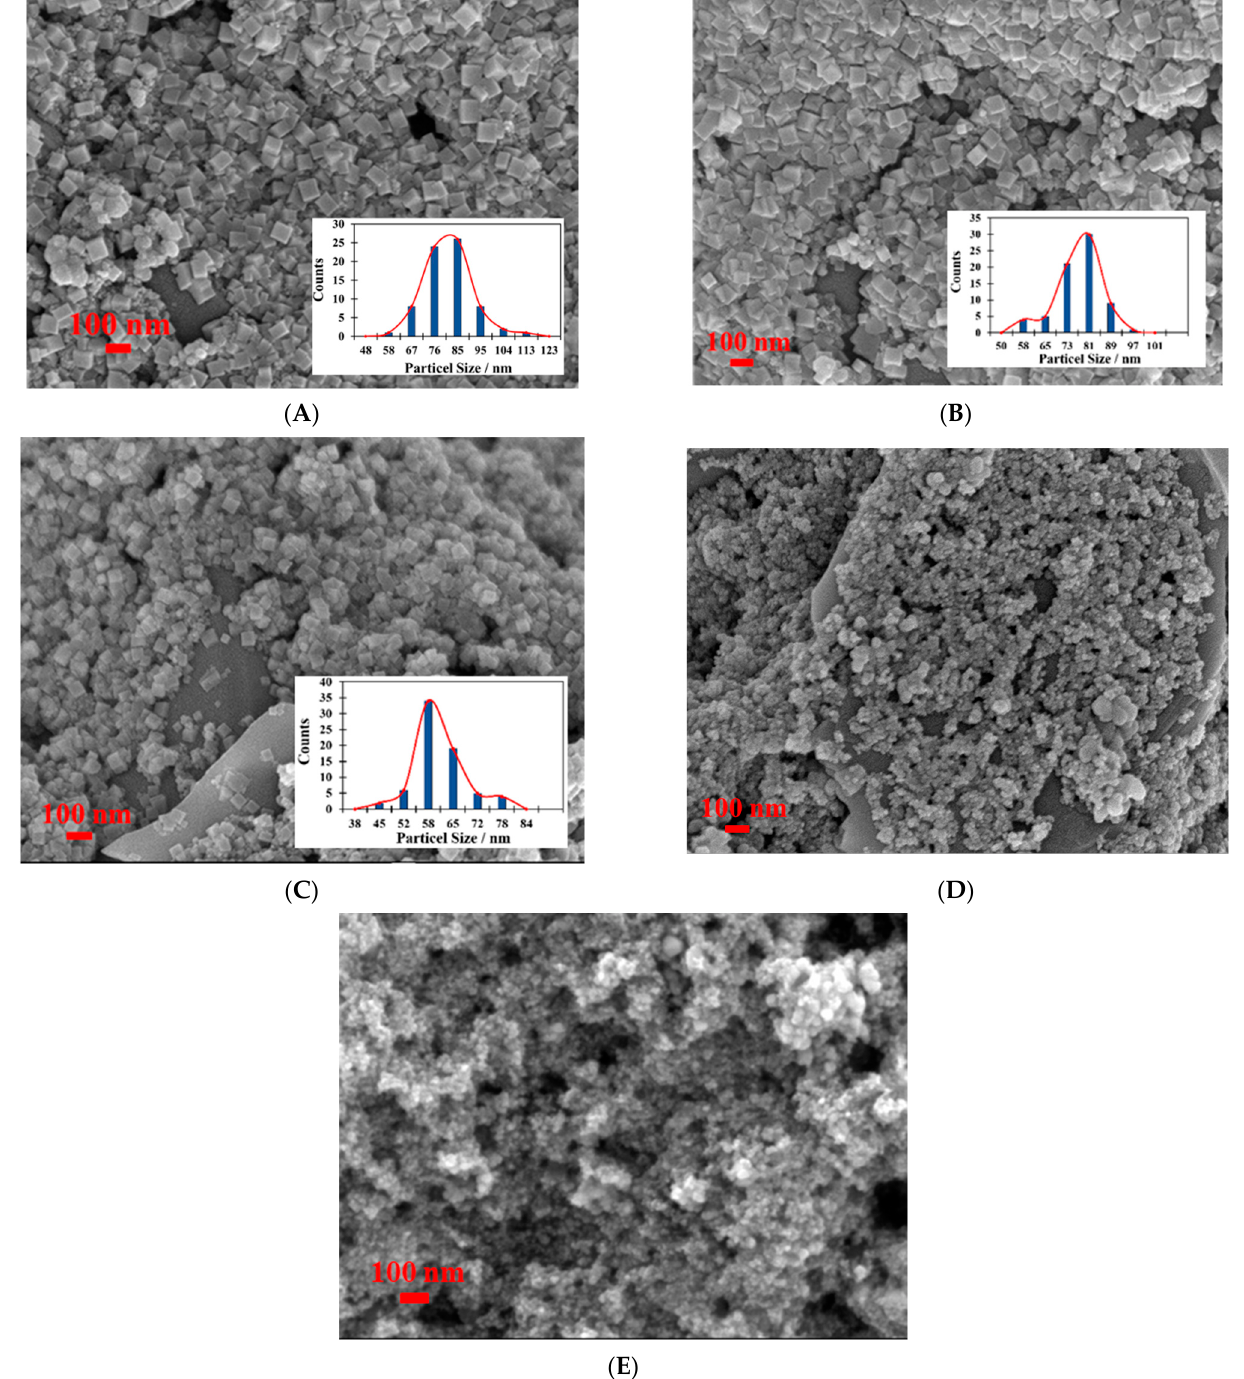
Figure 3. ( A – D ) SEM images of the SPCE/nano-Fe 3 O 4 /PBNC obtained from ( A ) Solution I, ( B ) Solu- tion II, ( C ) Solution III, and ( D ) Solution IV. Inset: the corresponding PBNC particle size distribution graphs ( n = 70). ( E ) SEM image of SPCE/nano-Fe 3 O 4 . It is considered that the nano-Fe 3 O 4 not only acts as active substrates for PBNC growth but also provides iron ions, Fe 3+ and Fe 2+ , responsible for PBNC deposition. In order to investigate the contribution of the nano-Fe 3 O 4 to the electrochemical reactions in Solution I, cyclic voltammetry is carried out with a bare SPCE (without nano-Fe 3 O 4 load- ing). As indicated in Figure S3A, a typical redox peak of Fe(CN) 63 − /Fe(CN) 64 − appeared at